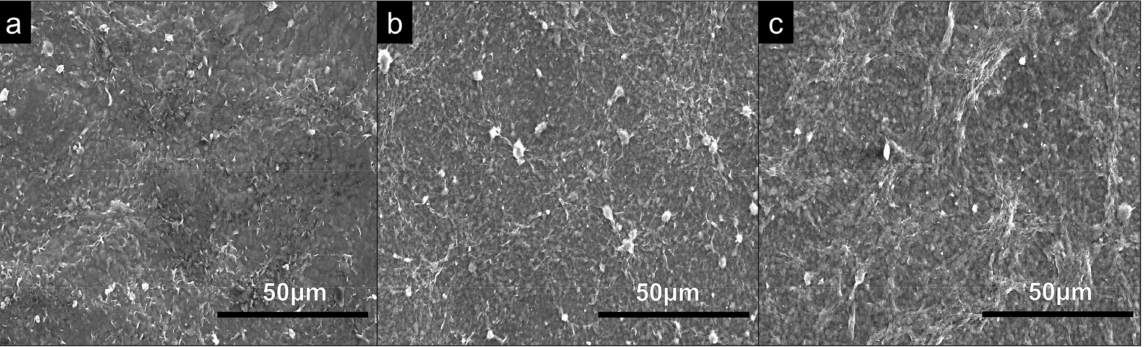
Figure 2. SEM analysis of 60 QL ( a ) PEI, ( b ) PDDA and ( c ) CHI coatings on glass microscopic slides examined at a magnification of × 1k.